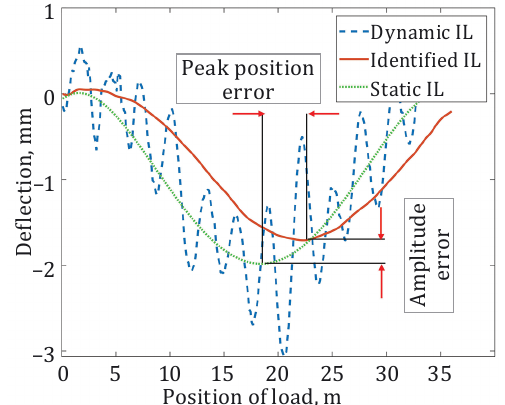
m0 Figure 4. Two kinds of errors: amplitude error and peak position error Position of load,